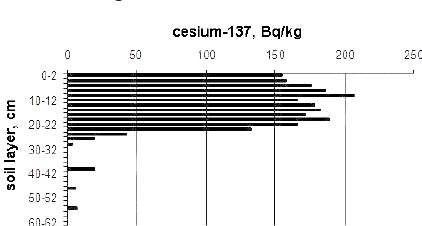
Figure 2. Diagram of cesium-137 radioactivity for different soil layers at the watershed on test area, background radioactivity value is established accordingly to the radioactivity of 20 cm soil layer (180